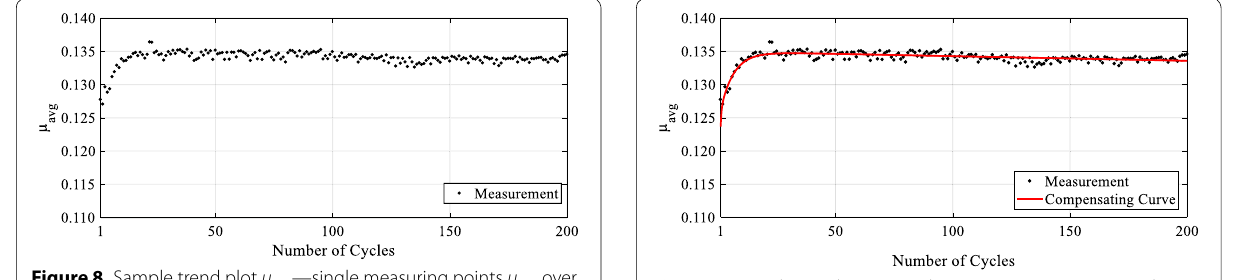
Figure 9 Sample trend µ avg —single measuring points µ avg and compensation curve